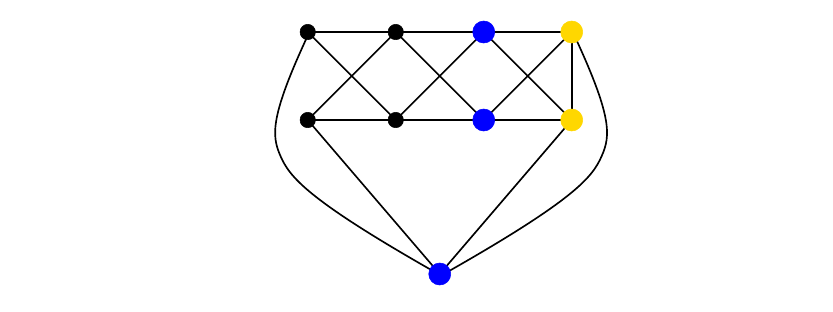
Figure 1: A graph G with ∆( G ) = 4 and χ ( G ) = 3 . The blue independent 3 -set realizes ivs χ ( G ) = 3 and the yellow 2 -set realizes vs χ ( G ) = 2